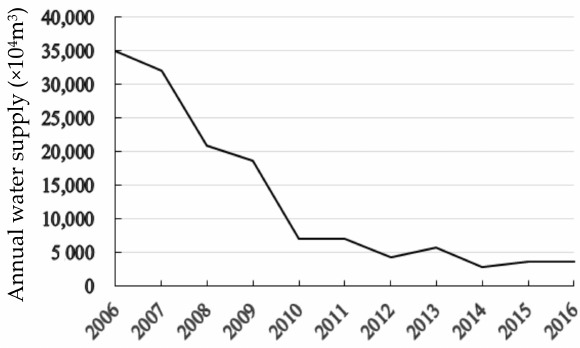
Figure 6. Groundwater availability of HYS from 2006 to 2016.